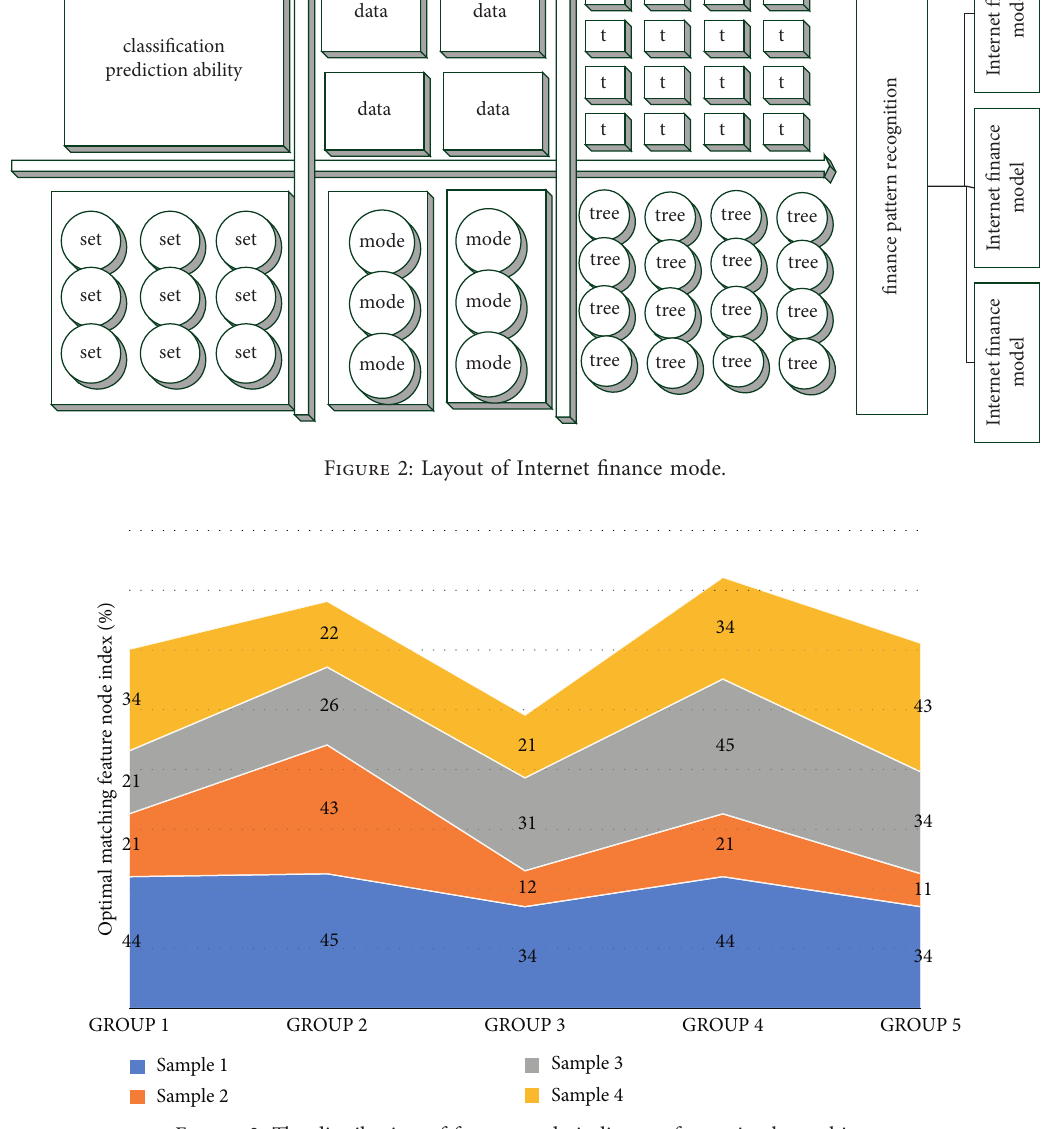
Figure 3: The distribution of feature node indicators for optimal matching.